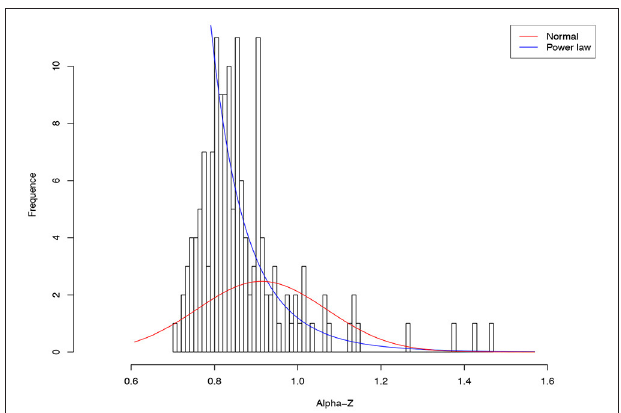
FIGURE 6 | Fitting the power law statistical distribution (Equation 10) and normal distribution to the alpha-DAR scaling parameter z (at diversity order q = 0) of 150 individuals in the HMP cohort: the power law distribution successfully fitted to z- values ( p = 0.999), but the normal distribution failed to fit ( p = 0.000) (also see Table 4